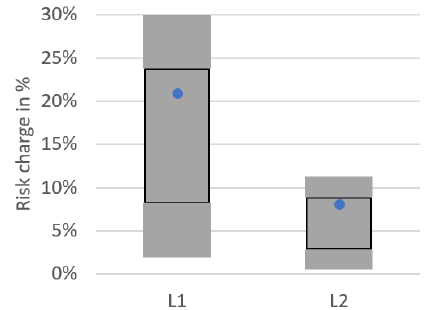
Figure 11. Comparison of the liabilities-only benchmark portfolios; representation based on own results (blue dot) and EIOPA (2021a, p. 25) (gray